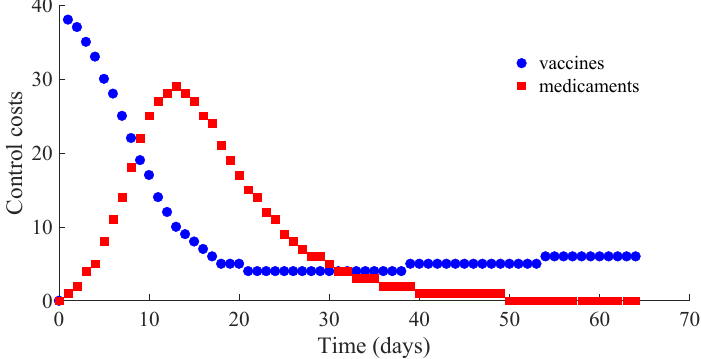
Figure 7. Number of vaccines and medicaments applied each day.